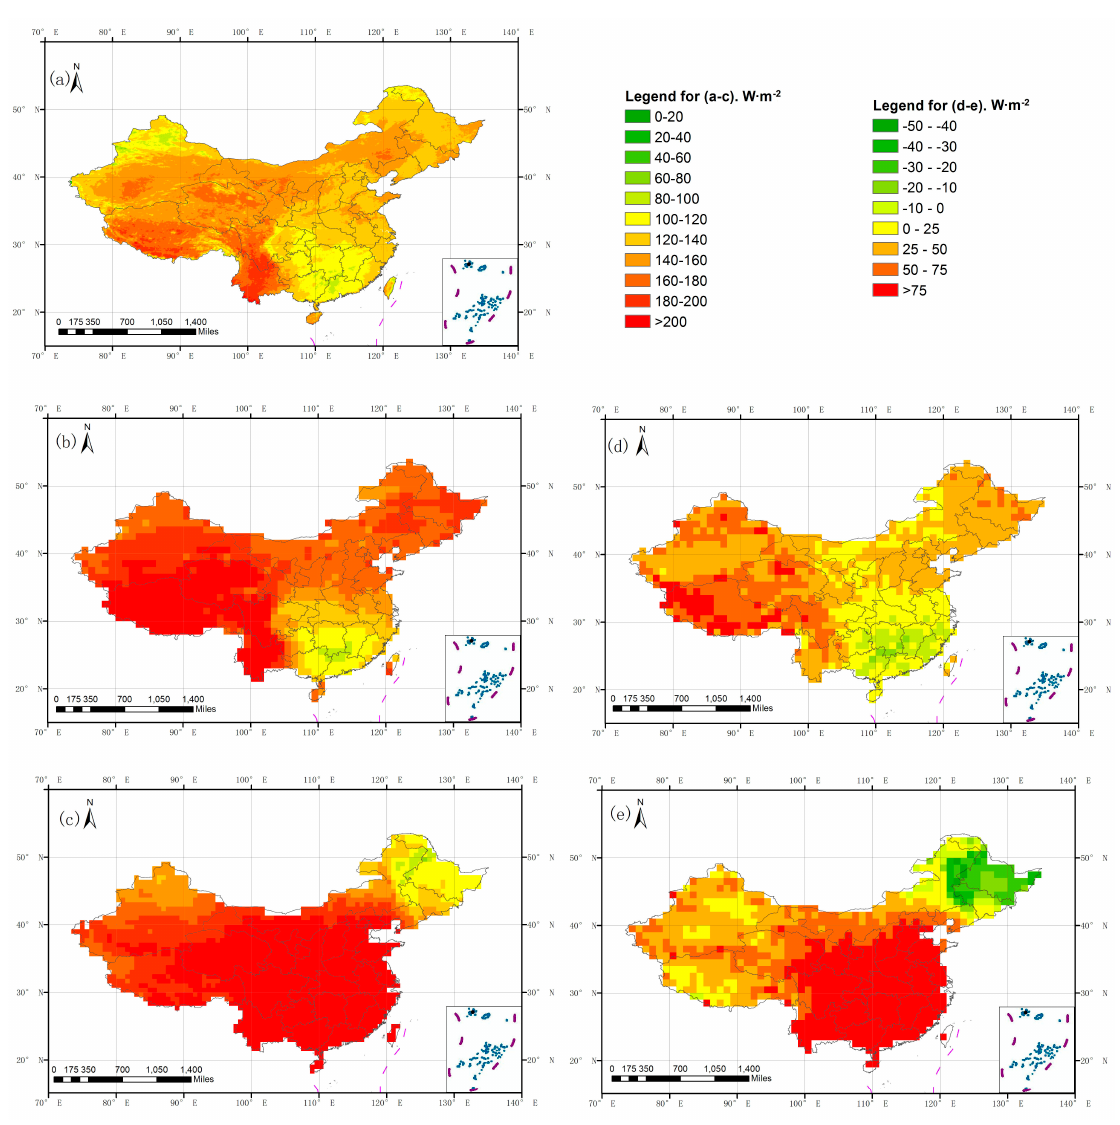
Figure 13. The spatial distribution of the DSR estimates from ( a ) the GBRT model, ( b ) the GEWEX-SRB, and ( c ) the MERRA in March 2003. ( d ) The differences between monthly mean DSR estimates of the GEWEX-SRB and the GBRT model (i.e., the GEWEX-SRB estimates minus the GBRT-based estimates) in March 2003. ( e ) The differences between monthly mean DSR estimates of the MERRA and the GBRT model (i.e., the MERRA estimates minus the GBRT-based estimates) in March 2003.